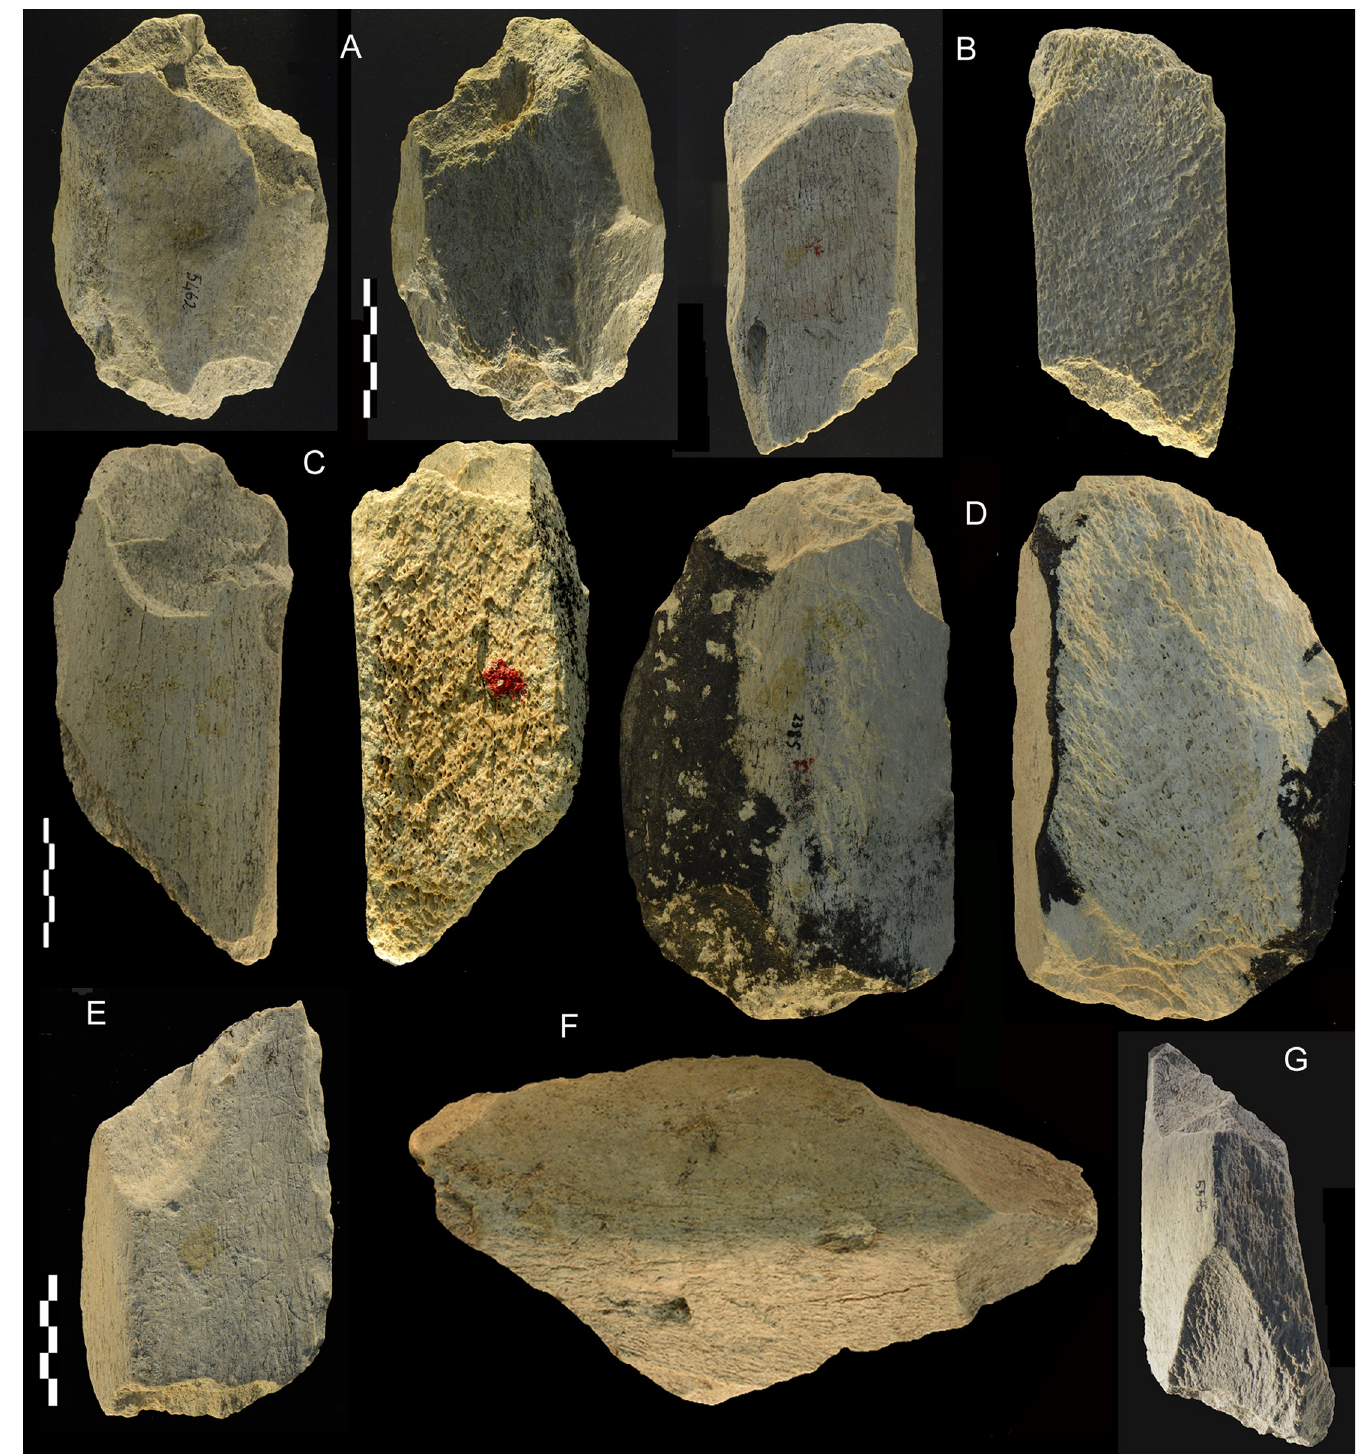
Fig 11. Castel di Guido. Intermediate tools (also called wedges). These tools, made on diaphysis fragments, show battering and crushing on the proximal end with some removal scars; the distal end has a broadly convex shape (A-D) or in some cases an end with a pointed morphology (E-G). They might have been used to work wood or to split bone. Catalogue numbers 5462, 4752, 5439, 2385,1294, 5500, 5575. Scale bar 5 cm.